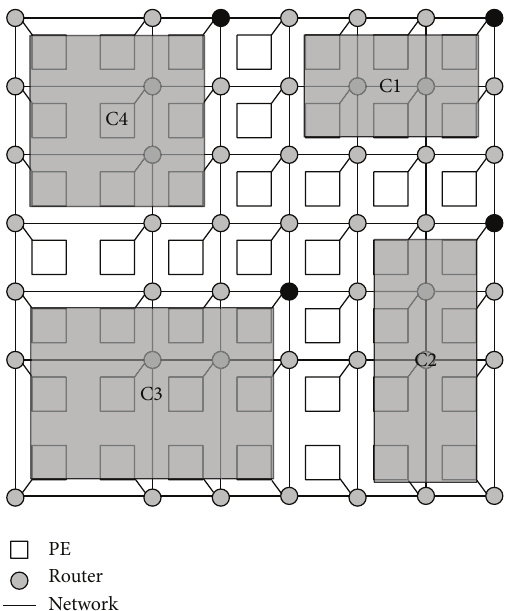
Figure 1: The DyNoC architecture [1].